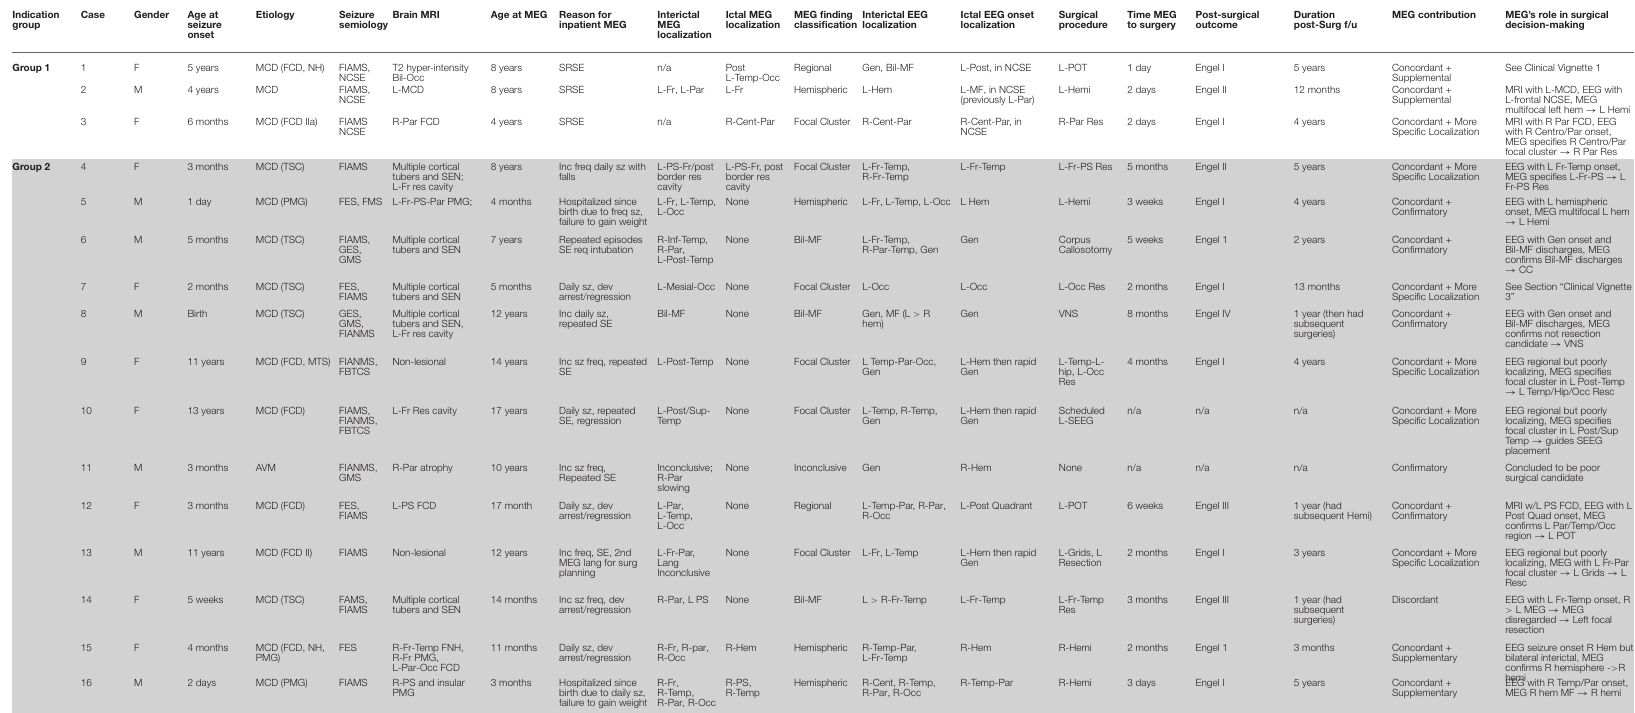
TABLE 1 | Findings and characteristics of subjects. (Followed by the already existing explanation of abbreviations). Indication